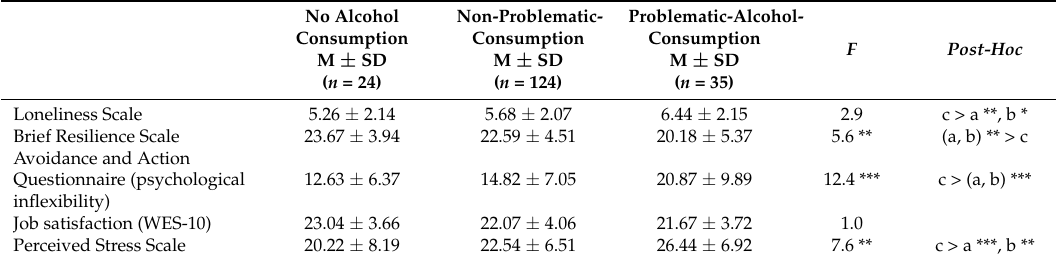
Table 2. Psychosocial variables associated with the alcohol consumption level (AUDIT) in male professors ( n =